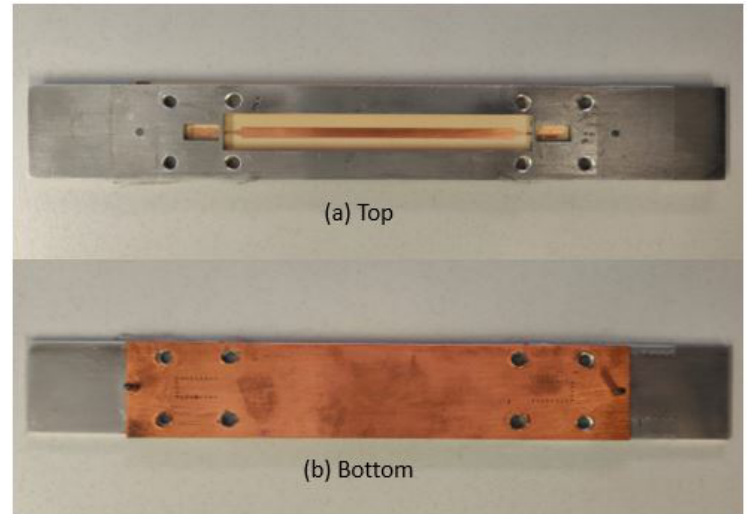
Figure 8. Top view and bottom view of the B2B manufactured TS transition.